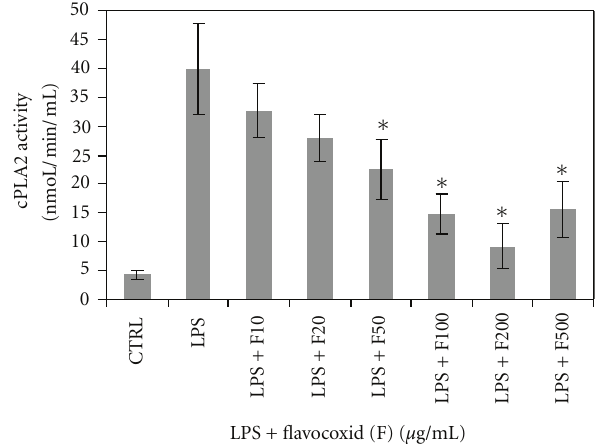
Figure 2: Cellular phospholipase A2 activity in rat peritoneal macrophages exposed to flavocoxid (F) at 10, 20, 50, 100, 200, and 500 μ g/mL in the presence of lipopolysaccharide